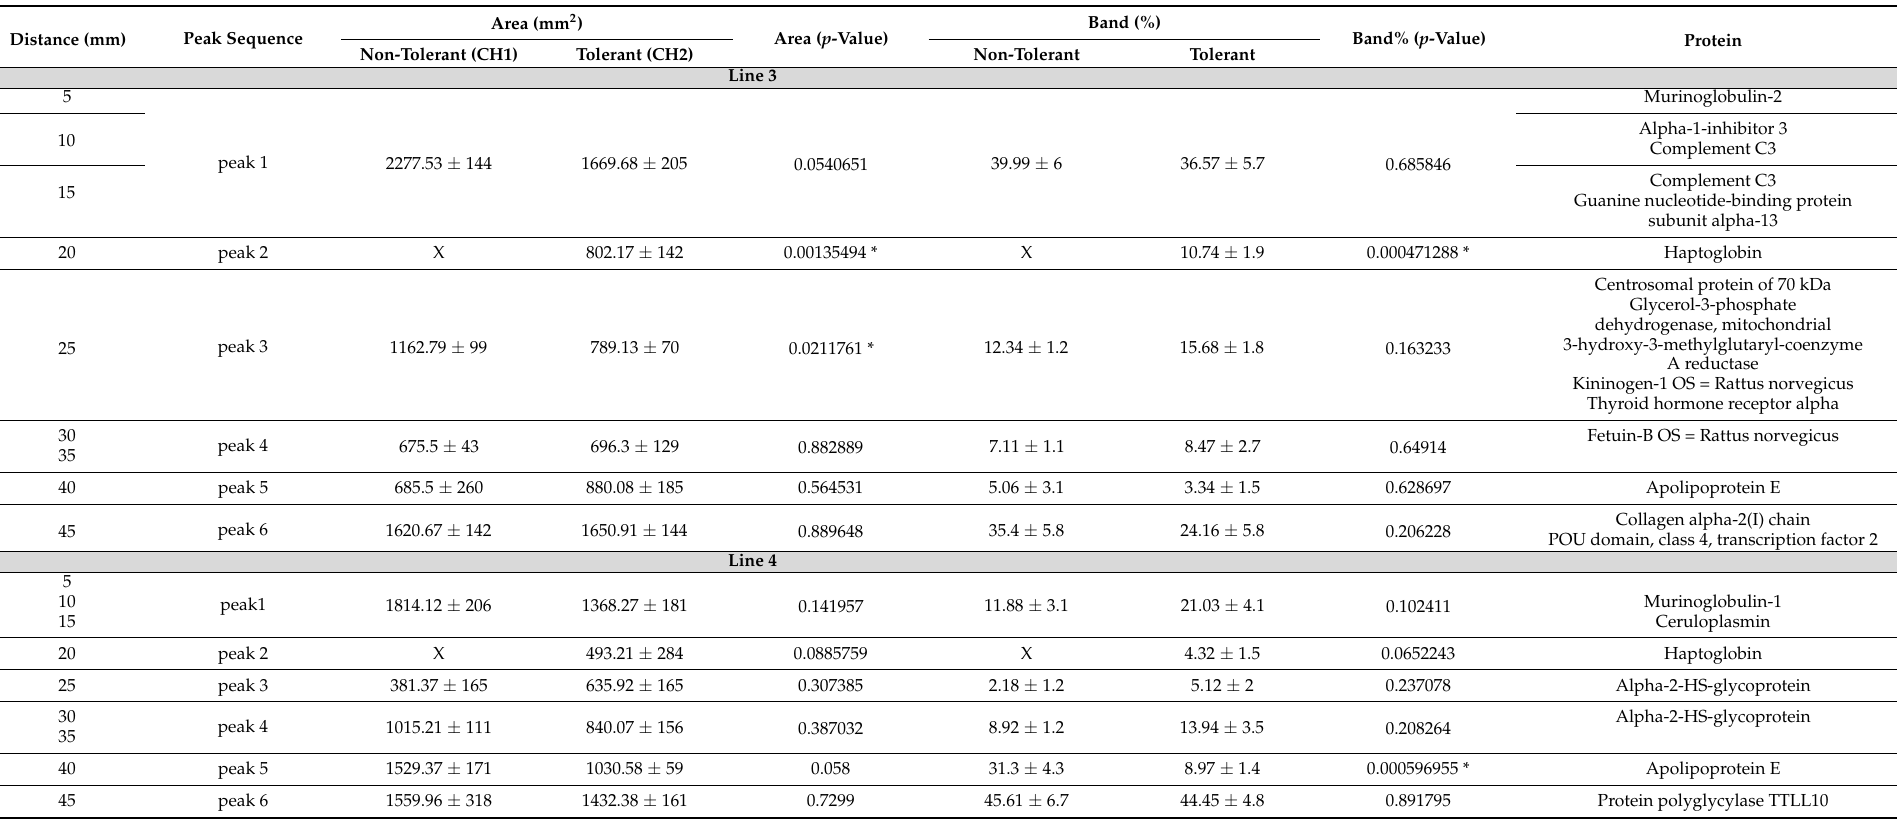
Table 1. The proteins identified in biologically active fractions of blood cell-derived secretomes drawn from remote ischaemic conditioning (RIC)-stimulated (tolerant) and non-RIC-stimulated (non-tolerant) rats. The biologically active content of the blood secretome was divided into fractions according to the distance from the top of the separation gel after electrophoretic separation and assigned to peaks according to the lane. The peak area (mm 2 ) and the percentage of the total area of the peaks in lane (band %) and p -value, resulting from statistical comparisons of the datasets are presented. (* p <